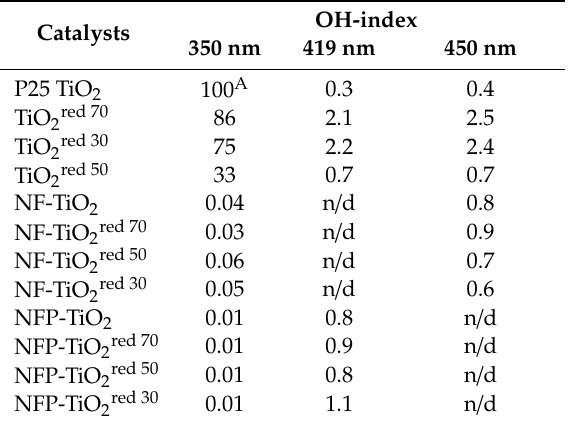
Table 3. Calculated OH-index of prepared TiO 2 materials.